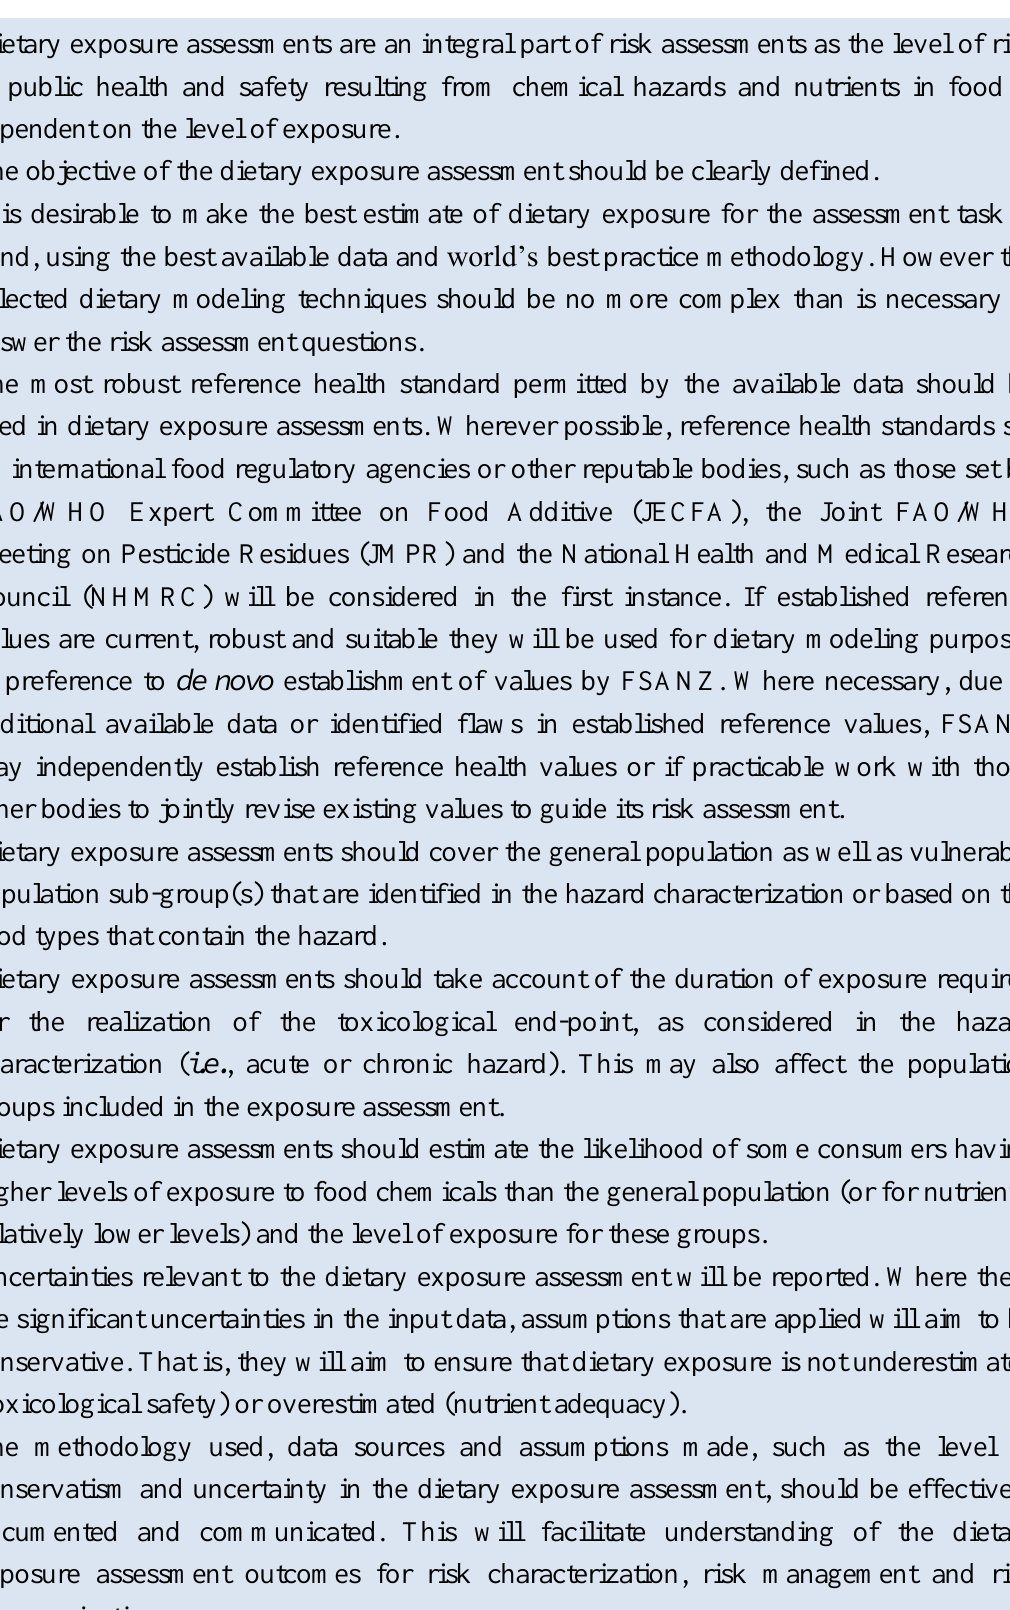
Figure 3. FSANZ’s best practice principles to underpin dietary modeling